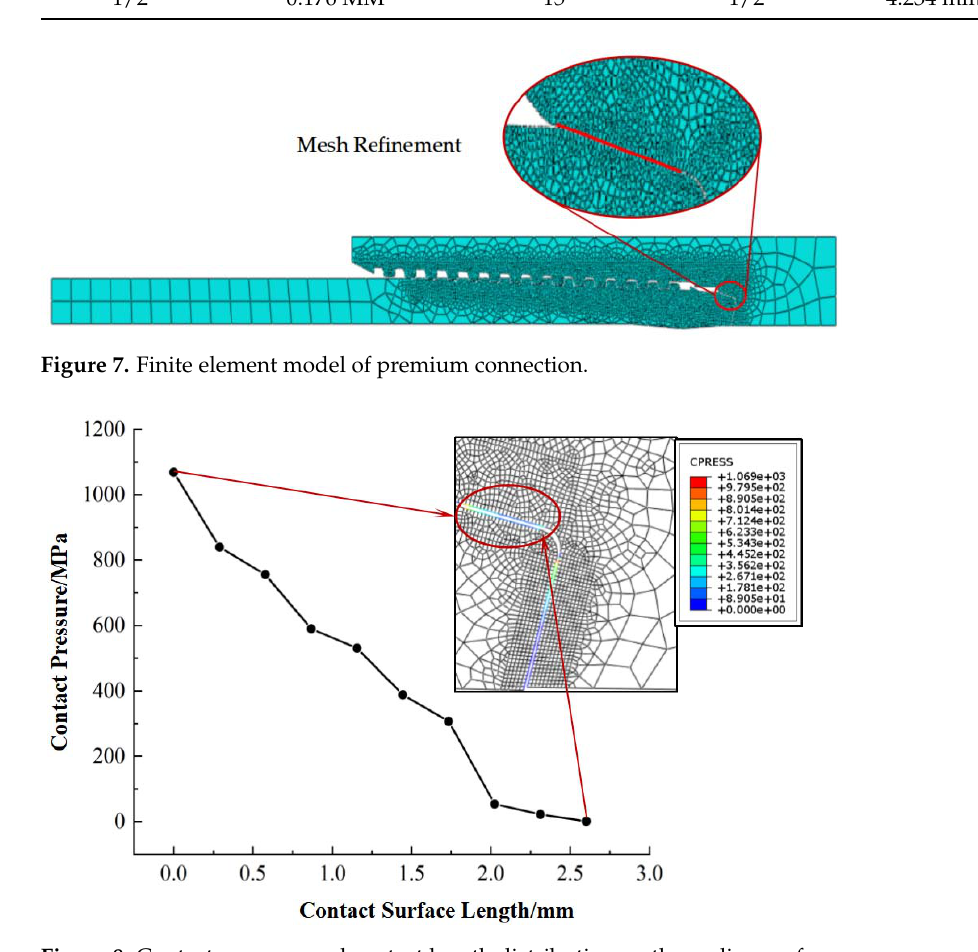
Figure 8. Contact pressure and contact length distribution on the sealing surface.